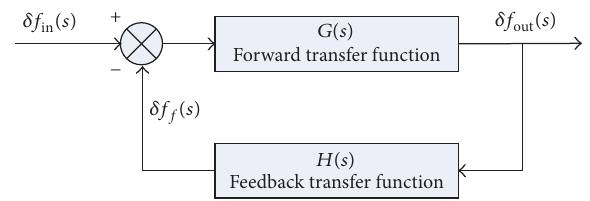
Figure 1: Schematic of a feedback control system.